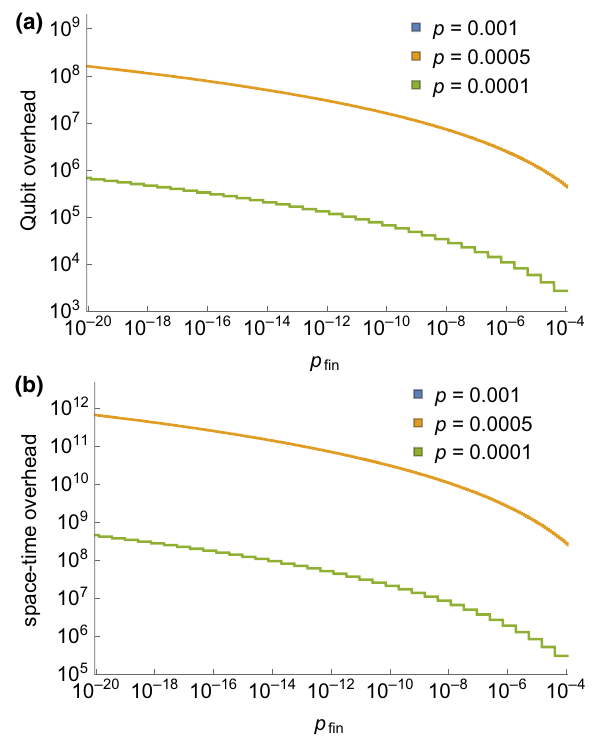
FIG. 32. (a) The qubit and (b) space-time overhead of code switching as a function of the infidelity p fin of the output T state. Note there is no curve for p = 0.001 as this is higher than the observed threshold for code